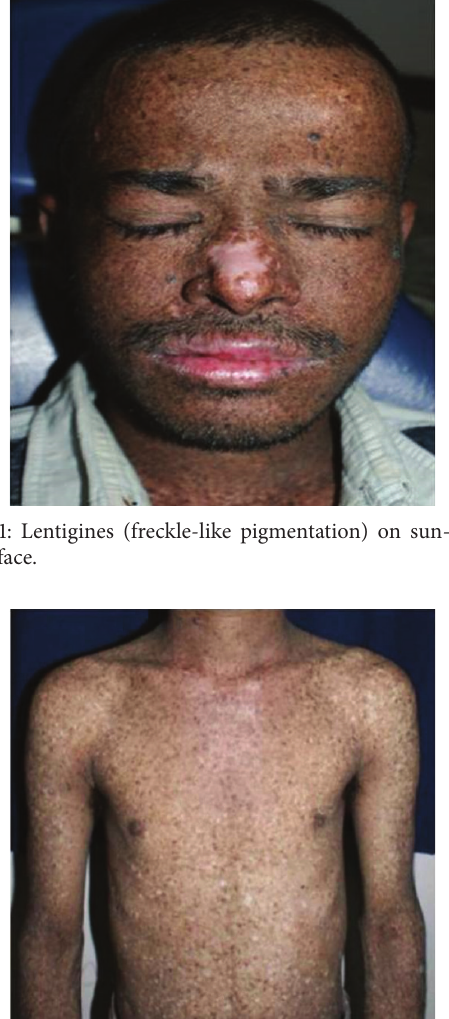
Table 1: Exogenous DNA damaging agents.